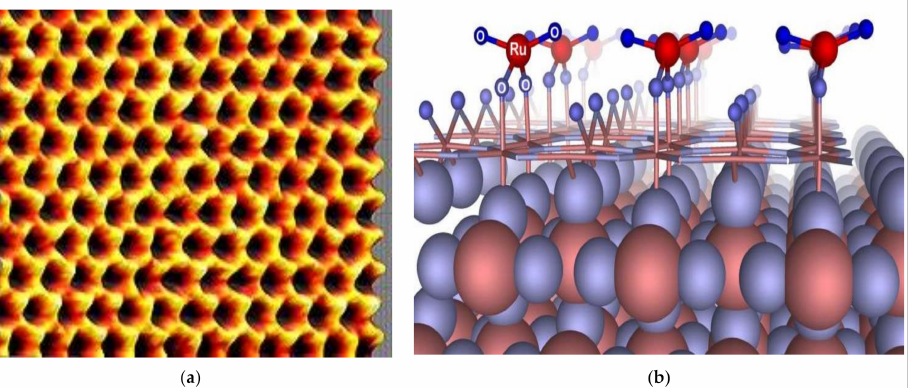
Figure 5. ( a ) Scanning probe microscopy image of graphene, ( b ) pseudocapacitance surface of RuO 2 cathode